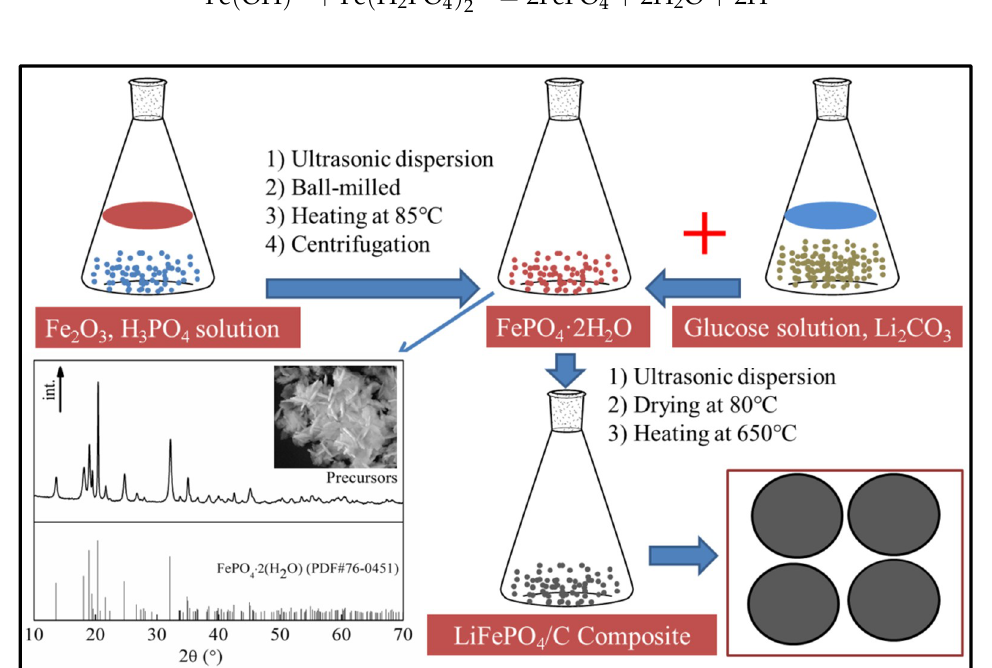
Figure 1. Schematic illustration for the preparation of the LiFePO 4 /C composite.